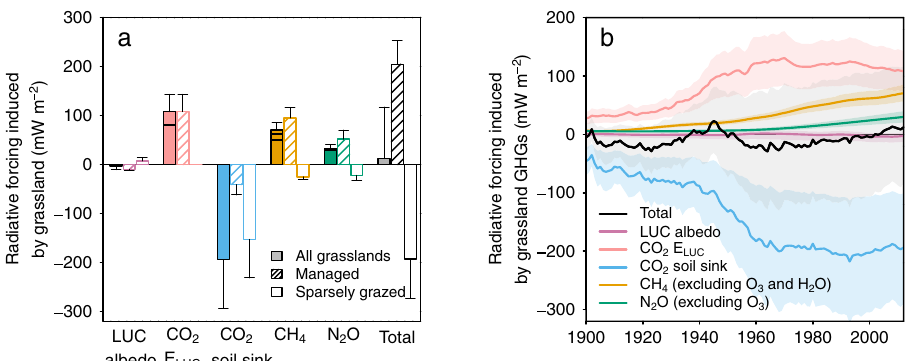
Fig. 4 Radiative forcing induced by direct and indirect human activities on grasslands worldwide a in the year 2012 and b for the period 1900 – 2012. The ‘ Total ’ column/line is the total contribution of grassland to the global radiative forcing (RF), accounting for the land-use change induced albedo change related to grassland, land-use change emission related to grassland (CO 2 E LUC ) and the three grassland greenhouse gas (GHG) fl uxes (CO 2 soil sink, CH 4 and N 2 O). In a , the RF of each component is further divided for managed and sparsely grazed grasslands, and is shown as an empty bar outlined in the same colour with (managed grasslands) and without (sparsely grazed grasslands) hatching, respectively. The stacked bar for CO 2 E LUC includes, from bottom to top, the effect from deforestation to pasture and conversion of grassland to cropland. The stacked bar for CH 4 includes, from bottom to top, the direct effect from CH 4 , and its associated effects through tropospheric O 3 and lifetime change induced by ozone precursors, and stratospheric H 2 O. The stacked bar for N 2 O includes, from bottom to top, the direct effect from N 2 O, and its associated effects through stratospheric O 3 . The uncertainties shown in a are 1-sigma standard deviation. The coloured shaded areas in b are the 1-sigma con fi dence interval derived from our uncertainty assessment (see ‘